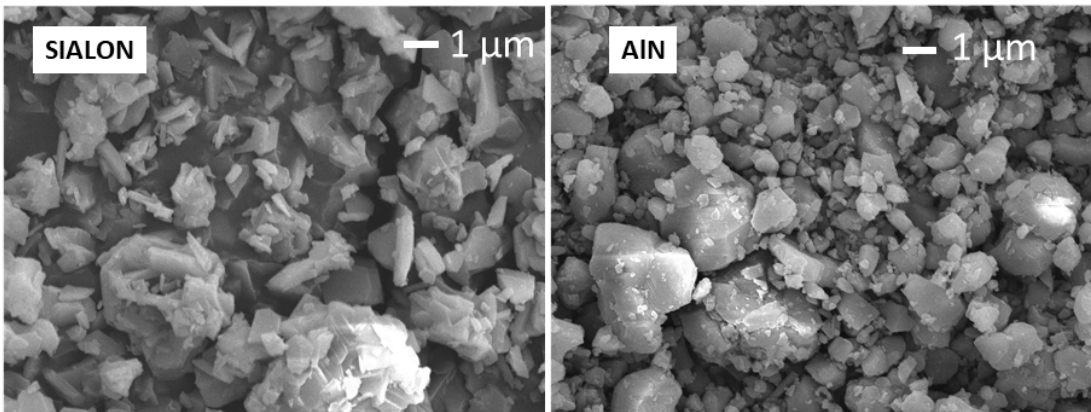
Figure 1. SEM images of the particles Sialon and AlN.